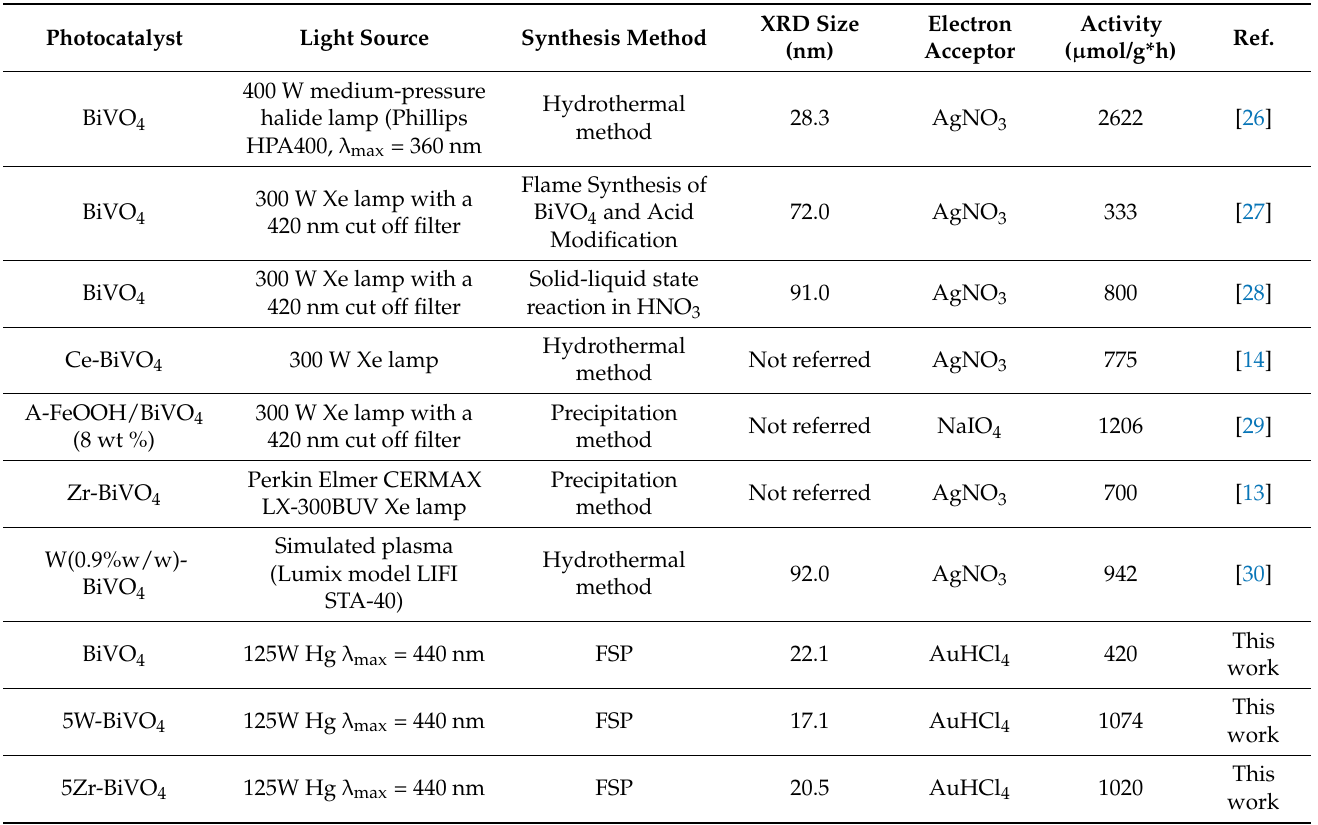
Table 3. Comparison of the O 2 evolution rate from BiVO 4 -based